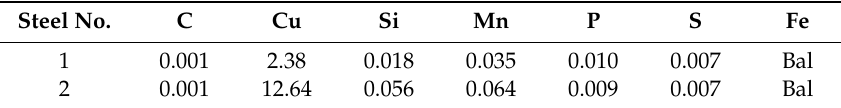
Table 1. Compositions of test steels (mass